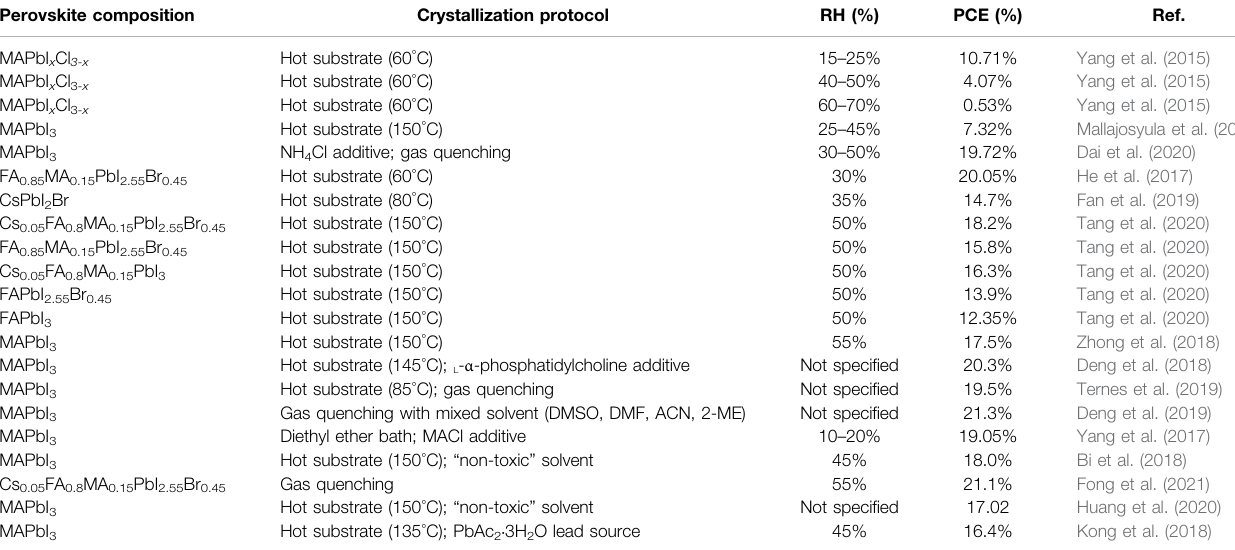
TABLE 2 | Comparison of some representative PSCs with perovskite thin fi lms fabricated by the blade-coating method in the ambient environment. Perovskite composition Crystallization protocol